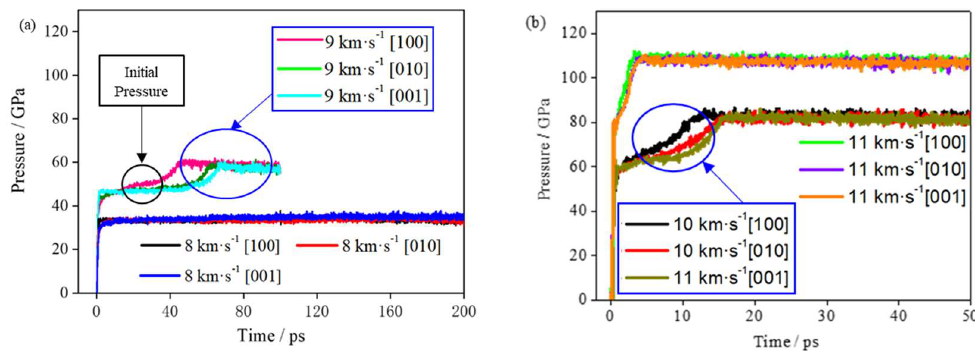
Figure 3. ( a ) Evolution of pressure at 8 and 9 km · s − 1 . ( b ) Evolution of pressure at 10 and 11 km · s − 1 .